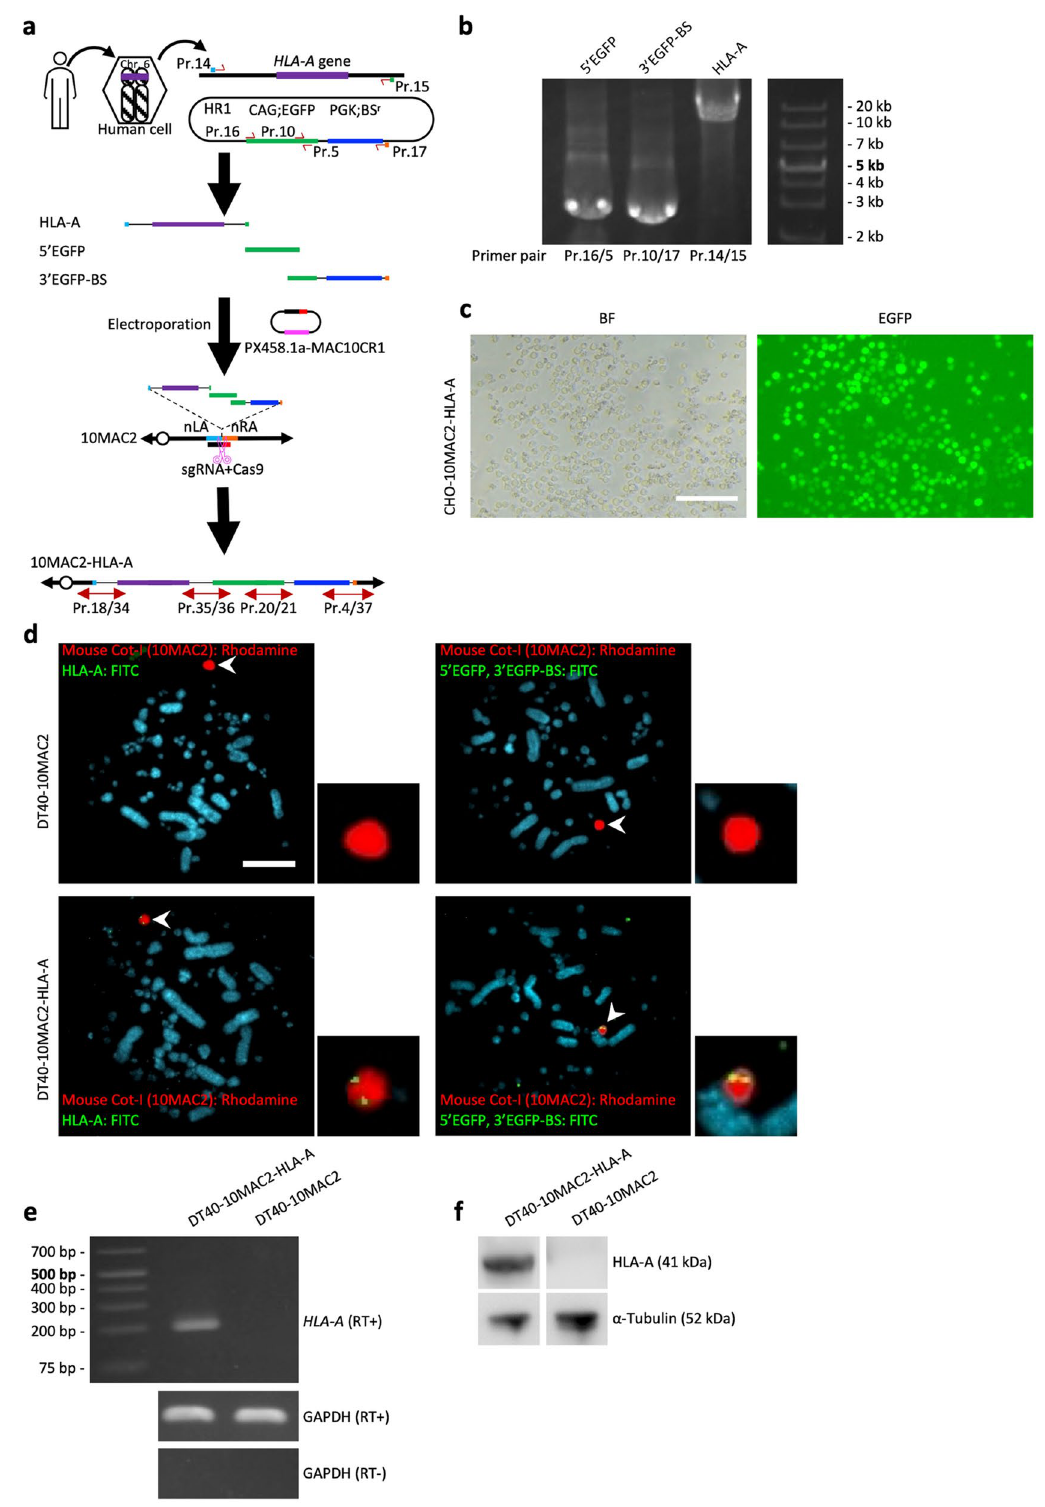
Figure 4. The simHDR based direct cloning of HLA-A genomic region. ( a ) Schematic representation of the simHDR illustrating the loading of genomic DNA sequence from human cells onto the 10MAC2. Arrows indicate the position of PCR primers used for analysis. ( b ) Preparation of PCR HDR donor fragments. Confirmation of precise amplification by electrophoresis. For gel source data, refer to Supplementary Fig. S15. ( c ) Image of DT40 cells carrying the 10NAC2-HLA-A. EGFP expression indicates the presence of the 10NAC2-HLA-A. BF, bright field. Scale bar: 100 µm. ( d ) Representative image of metaphase FISH analysis with mouse Cot-I (red) detecting 10MAC2 and HLA-A or 5’EGFP and 3’EGFP-BS PCR HDR donor fragments (green). Arrowhead indicates the 10MAC2 and the inset shows an enlarged image thereof. Scale bar: 10 μm. ( e ) RT-PCR products generated from DT40-10MAC2-HLA-A and DT40- 10MAC2 cells cDNAs. Each end point PCR products are shown. For gel source data, refer to Supplementary Fig. S16. ( f ) Detecting HLA-A protein by western blotting. For membrane source data, refer to Supplementary Fig.